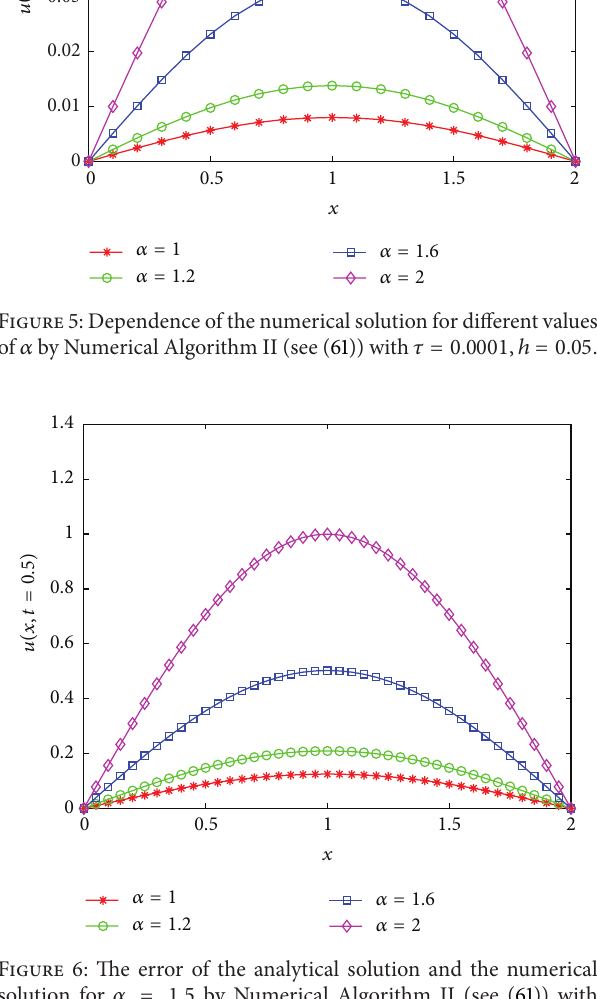
, ̃𝑅 𝑘 → 0 as Figure 6: The error of the analytical solution and the numerical 𝑙 𝑙 solution for 𝛼 = 1.5 by Numerical Algorithm II (see (61)) with 𝜏 = 0.04, ℎ = 0.002 .